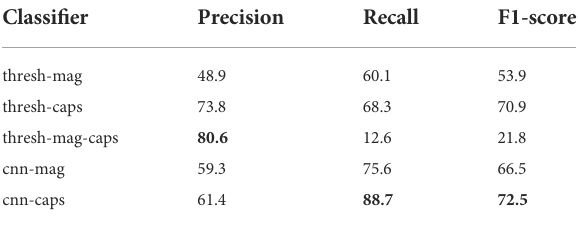
TABLE1Performancecomparisonfordifferentmodels.Precision(P)is the % of predictions which are correct. Recall (R) is the % of ground truth which are predicted correctly. F1-score is the harmonic mean of precision and recall (Eq. 4). Note that the tolerance for correct classi fi cation for ‘ thresh- ’ classi fi ers was set at ± 60 min from the ground truth crossing times. The bold values represent the model which achieved the best score for that speci fi c